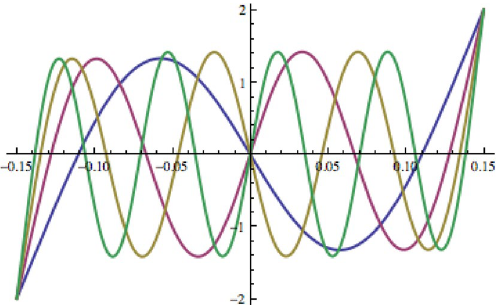
Figure 2. Mirror-symmetric eigenmodes of a free-free 30 cm thin beam. The first, second, third and fourth mirror-symmetric eigenmodes are depicted in blue, maroon, gold and green consequently. The eigenmode’s zero-crossing locations are at 0, ± 11.0368 cm compared to 0, ± 11.1012 cm derived from Eq. (24) for the free- hinged-hinged-hinged-free beam of the same